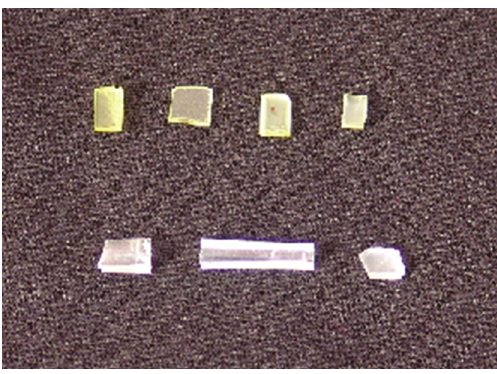
Figure 14: Photograph of electron irradiated L-threonine for various